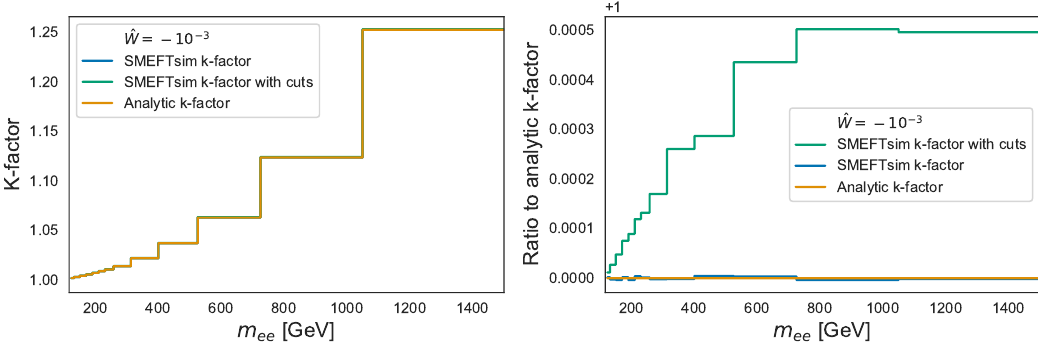
Figure 25 . Left: comparison of the SMEFT K -factors, eq. (3.10), linearised in the EFT parameters, between the numerical and the analytical approaches for ˆ W = − 10 − 3 and the kinematics of the ATLAS 7 TeV DY data. The label “cuts” indicates that we impose acceptance requirements of p ‘ ≥ 25 GeV and | η ‘ | ≤ 2 . 5 in the numerical ( SMEFTsim ) calculation. Right: relative difference in T the K -factors shown in the left panel taking the analytical calculation as a